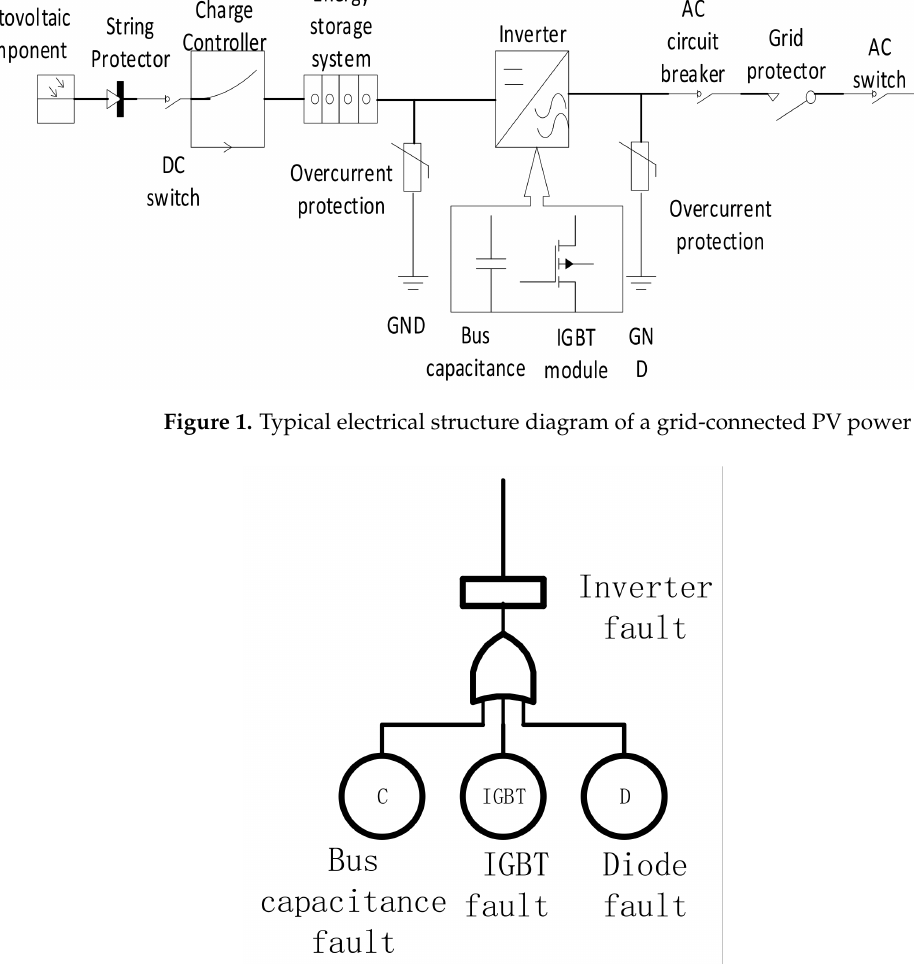
Figure 2. Inverter fault tree